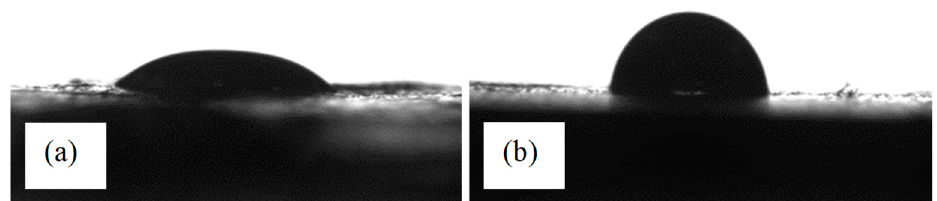
Figure 5. Contact angle images for ( a ) CMC and ( b ) CMC/CNC MCC/ BFO/PoPD nanocomposite film.